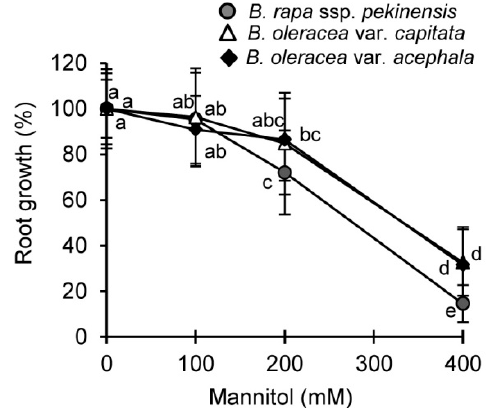
Figure 2. Root-growth assay of Brassica seedlings treated with mannitol (0–400 mM). Different letters present significant values ( p ≤ 0.05). Data are mean ± SD, n = 30–33.